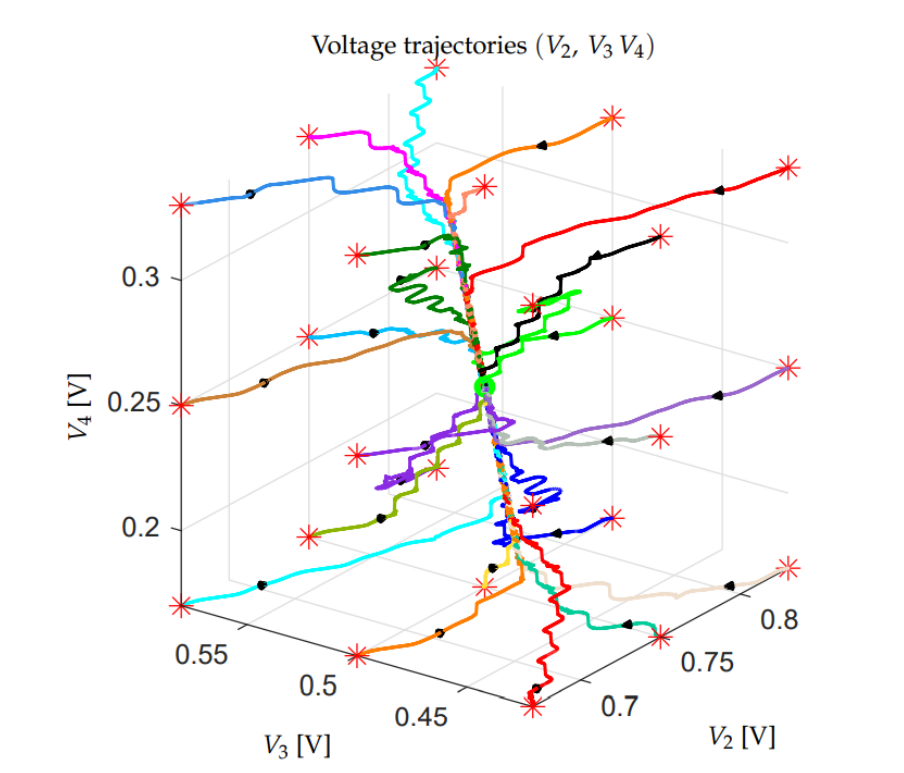
Figure 14. Stability of the Basic Configuration Voltage Vector V ∗ m = [ 4 3 2 1 ] T for n =